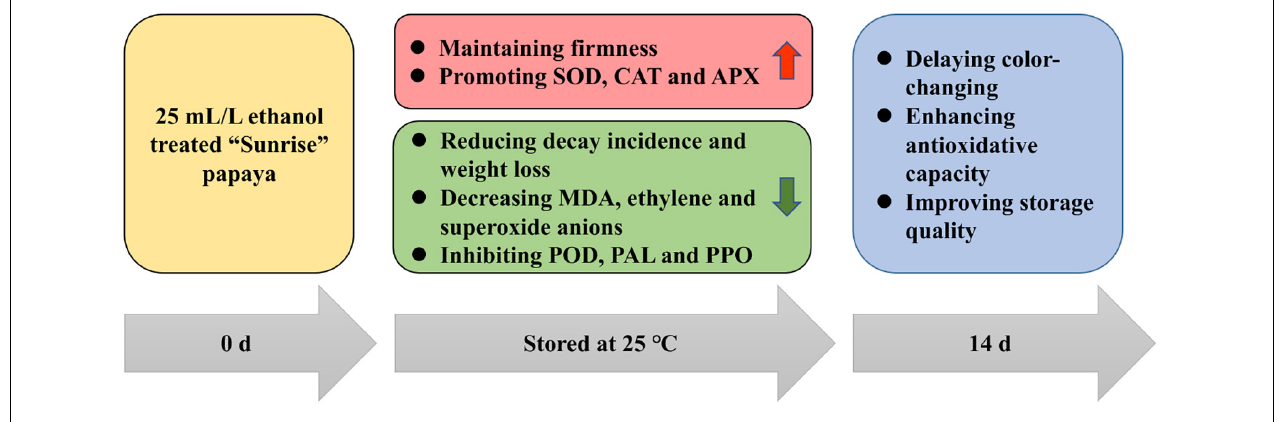
FIGURE 6 | Putative action pattern of ethanol treatment on postharvest